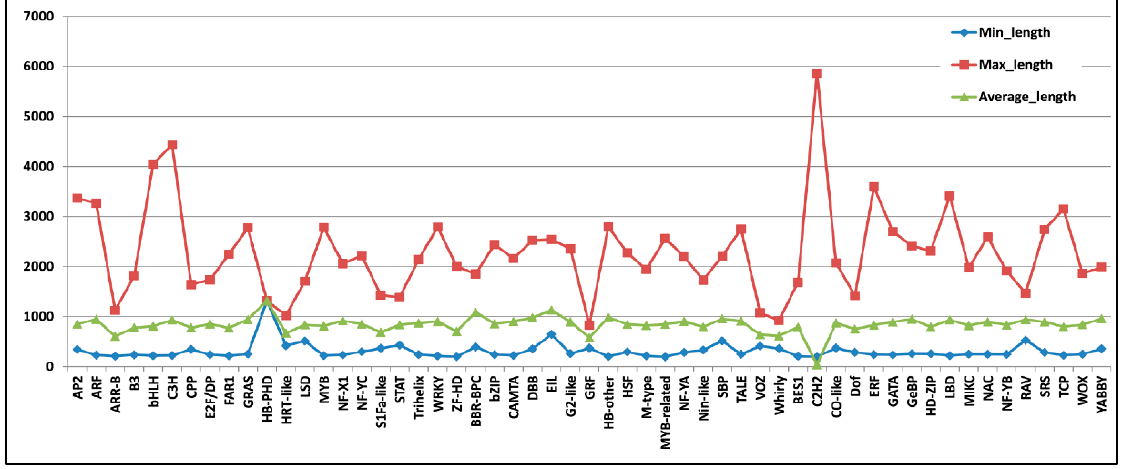
Figure 5. Line graph coverage graph of identified 4311 T. cordifolia transcripts categorized into 55 different TF categories based on minimum, maximum and average transcript length of each TFs category.